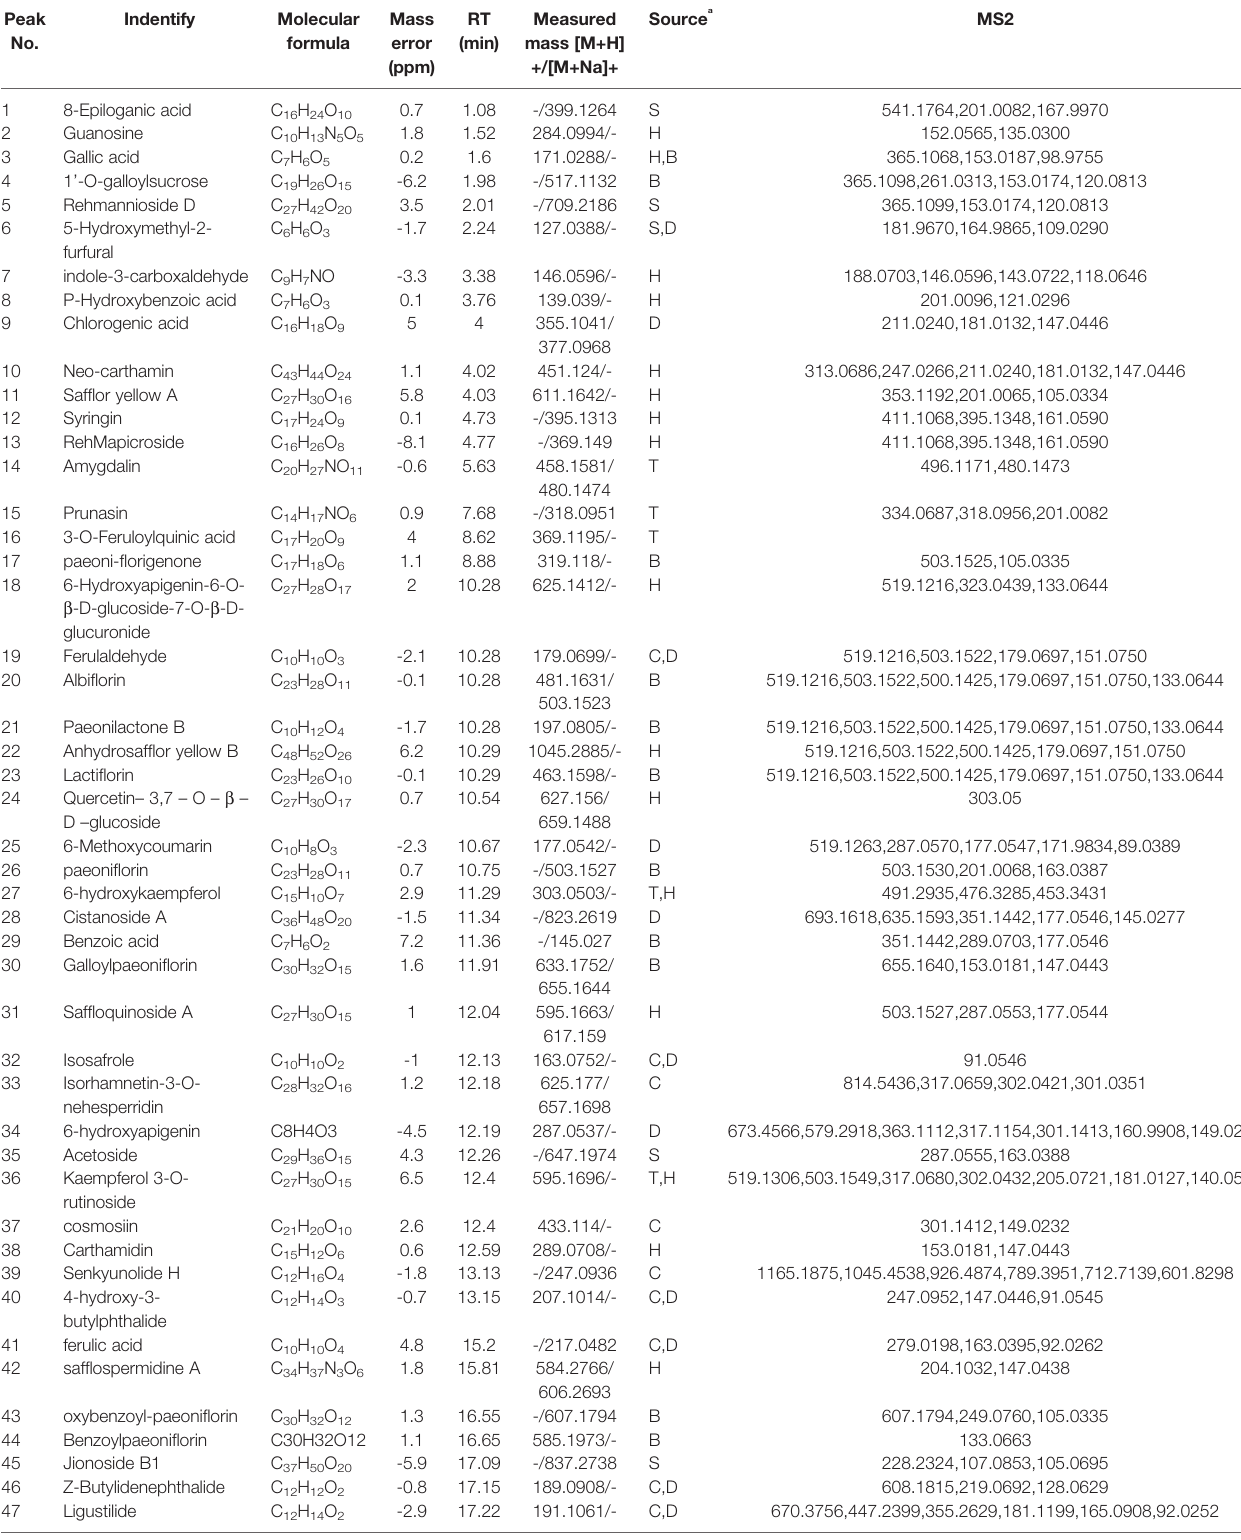
TABLE 1 | Compounds identi fi ed in THSWD by UPLC-Q-TOF-MS in positive ion mode. Peak